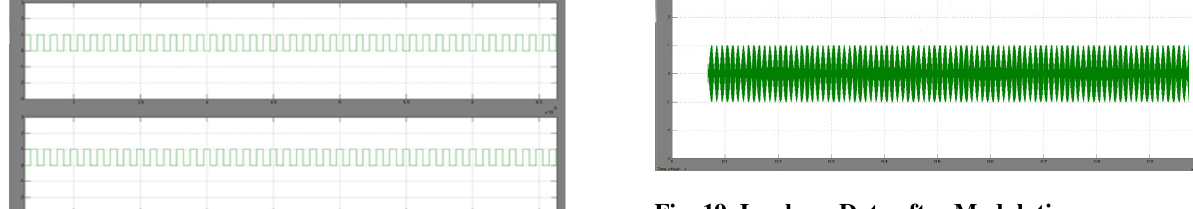
Fig. 19. In-phase Data after Modulation.